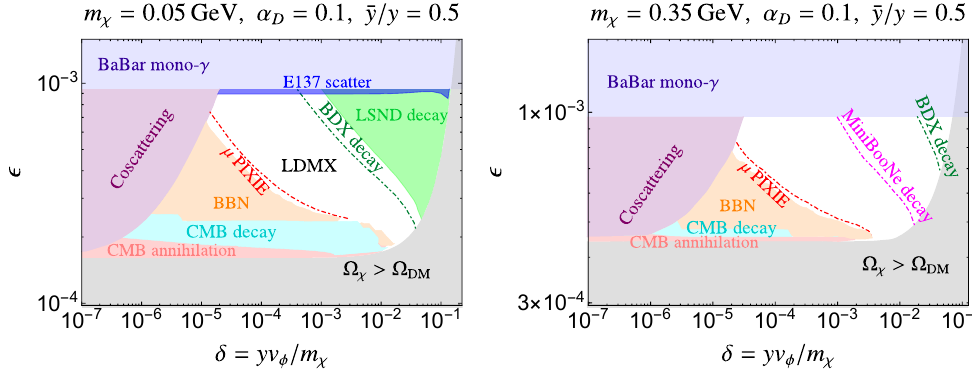
Figure 13 . Dark photon coupling, (cid:15) , vs. the size of the DM mixing with its coannihilating states, (cid:14) . When (cid:14) is su(cid:14)ciently small the relic density does not depend on it, as shown by the (cid:13)at (cid:10) (cid:31) > (cid:10) DM contour. On the contrary the lifetime of the heavier states, sharing a conserved quantum number with DM, increases as (cid:14) 2 , strongly a(cid:11)ecting the phenomenology. The bounds are discussed in the text and come from BaBar [150, 151], E137 [152], LSND [153], BBN [77, 78], and the CMB [154]. The reach for BDX and MiniBooNe adapted from [61], and PIXIE [154{157] (corresponding to (cid:22) < 5 (cid:2) 10 (cid:0) 8 ) are shown. LDMX [158] can probe the entire allowed region of the left panel, but is not sensitive to the heavier dark photon mass on the right panel. In every point of the plot (cid:1) is (cid:12)xed to reproduce the observed relic density. The remaining parameters are set to m (cid:31) = 0 : 05 (0 : 35) GeV, m A 0 = 3 m (cid:31) (1 + (cid:1)), (cid:11) D = 0 : 1, and (cid:22) y=y = 0 : 5 in the left ( right )